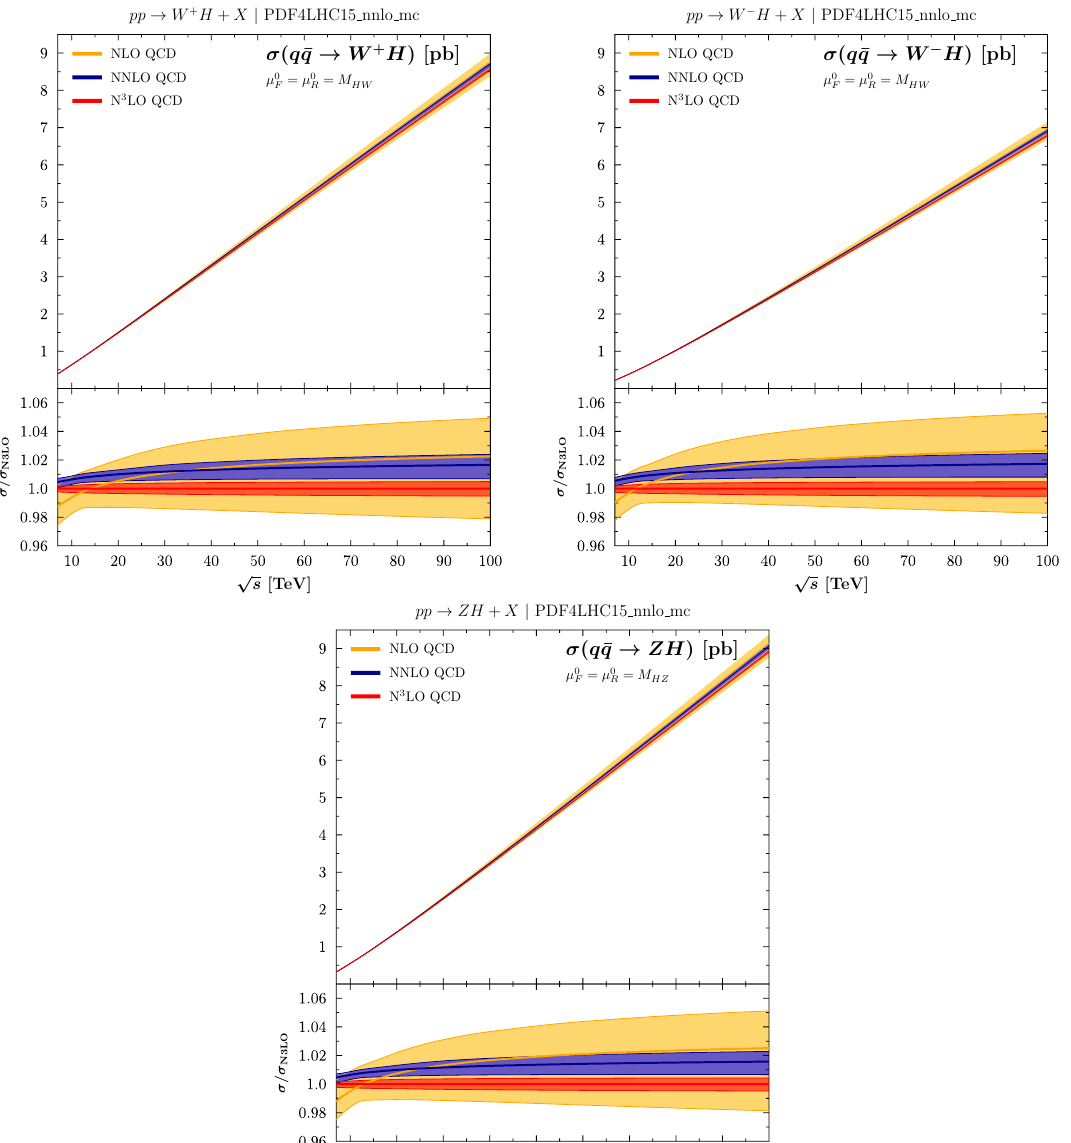
Figure 16 . Inclusive cross sections for the associated Higgs production with a massive gauge boson (in pb) at a proton-proton collider as a function of the c.m. energy (in TeV), up to N 3 LO in QCD in- cluding the 7-point scale uncertainty. All cross sections are calculated with the PDF4LHC15_nnlo_mc PDF set. The lower panels display the ratio to the central N 3 LO prediction. Upper row: W ± H predictions. Lower row: ZH